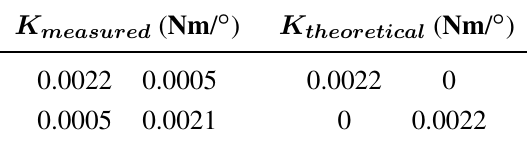
Table 1. The experimentally determined and theoretically calculated stiffness matrices corresponding to Figure